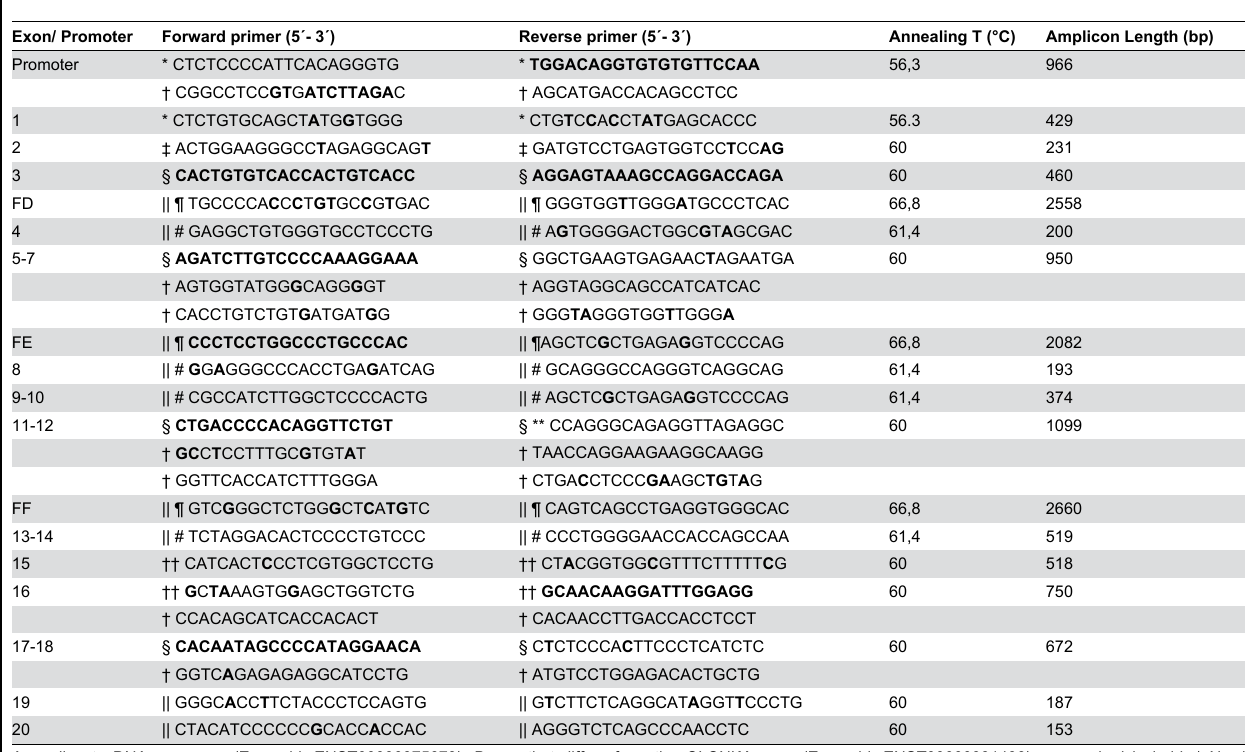
Table 2. PCR and sequencing primers for the analysis of the human CLCNKB gene.